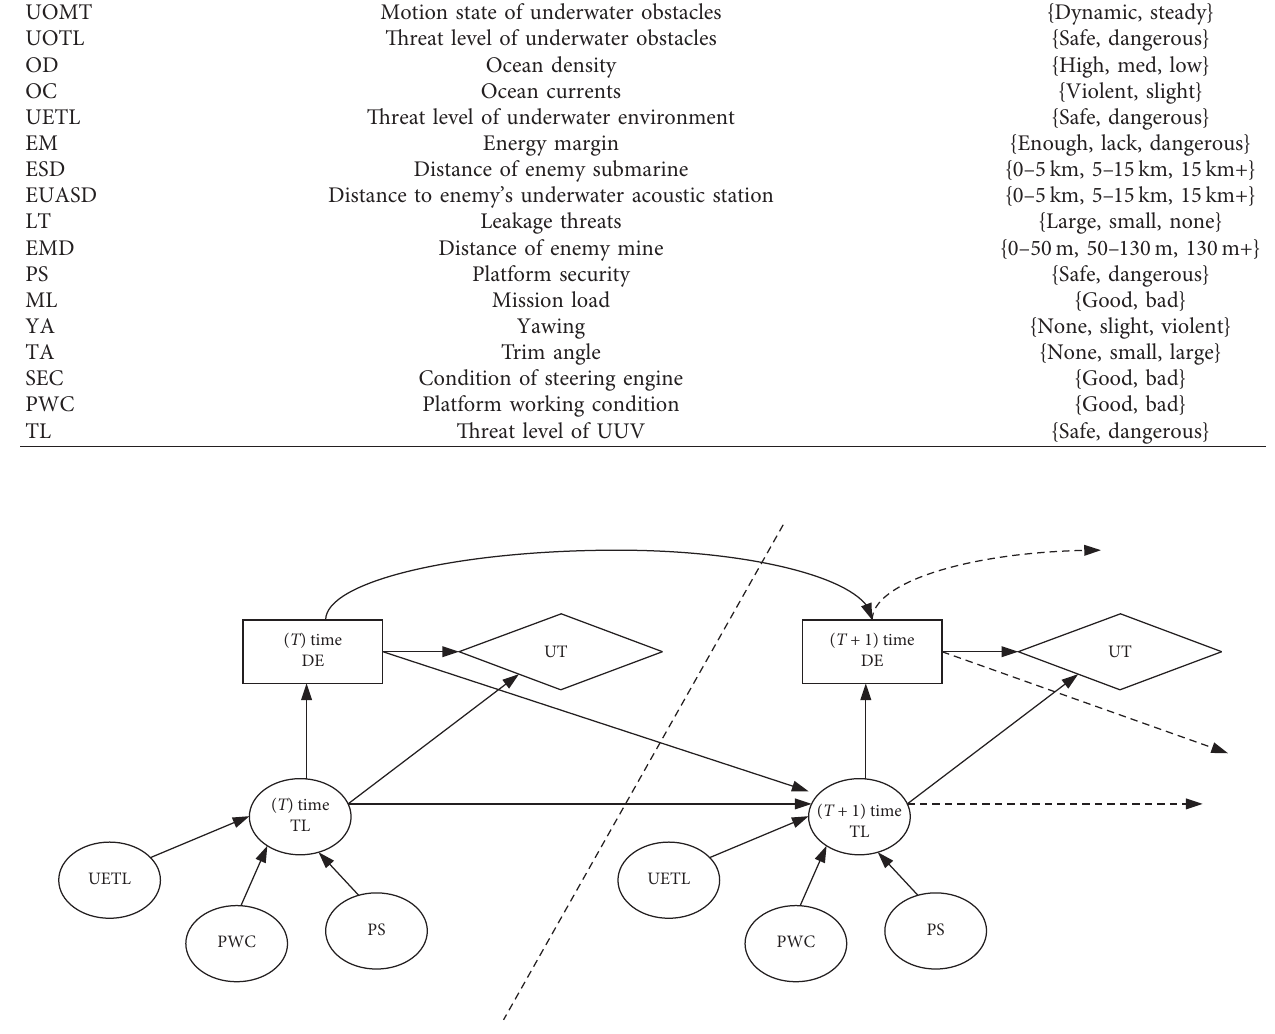
Figure 6: The DID model for the UUV’s autonomous